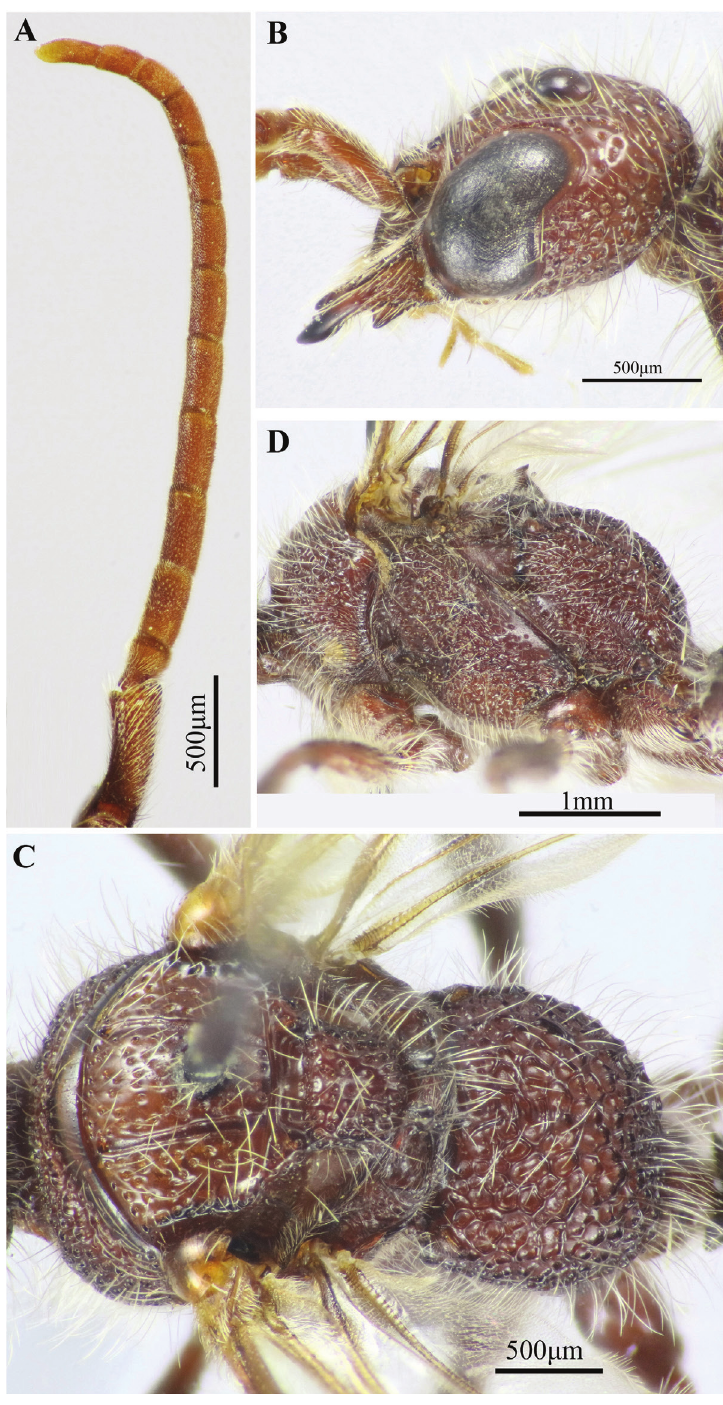
Figure 16. Pseudophotopsis mascatiana Invrea (Male) A antenna B head and antennal scape, lateral view C, D mesosoma, lateral and dorsal views,